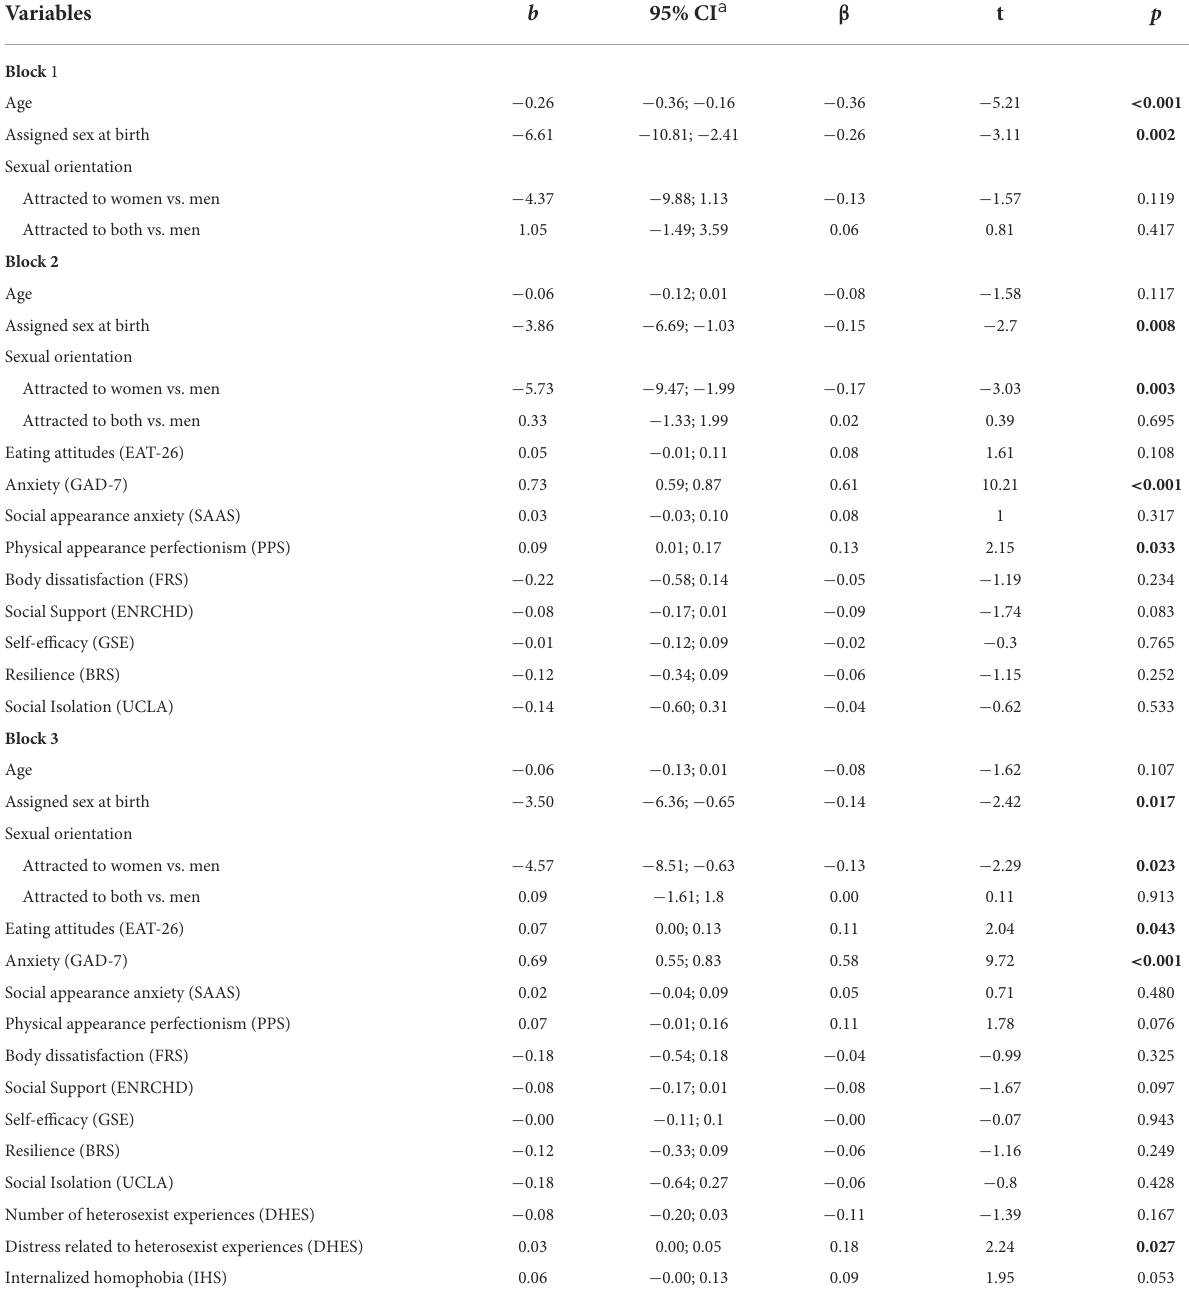
TABLE 3 Summary of the multiple hierarchical regression analysis predicting depressive symptomatology ( N =